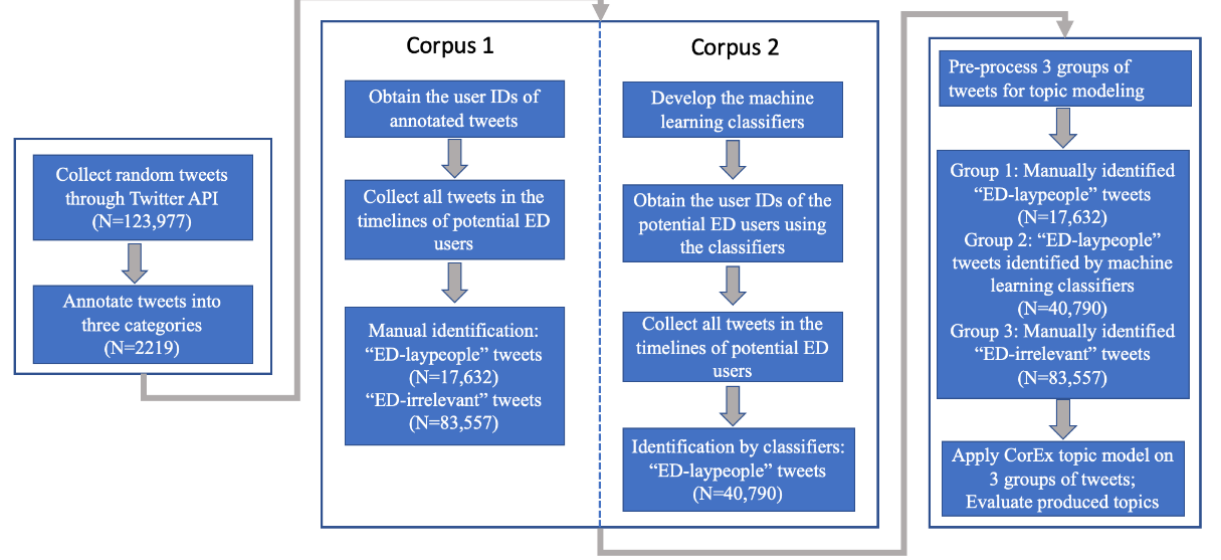
Figure 1. The workflow of the study. N represents the number of tweets at the corresponding step. CorEx: Correlation Explanation; ED: eating disorder.